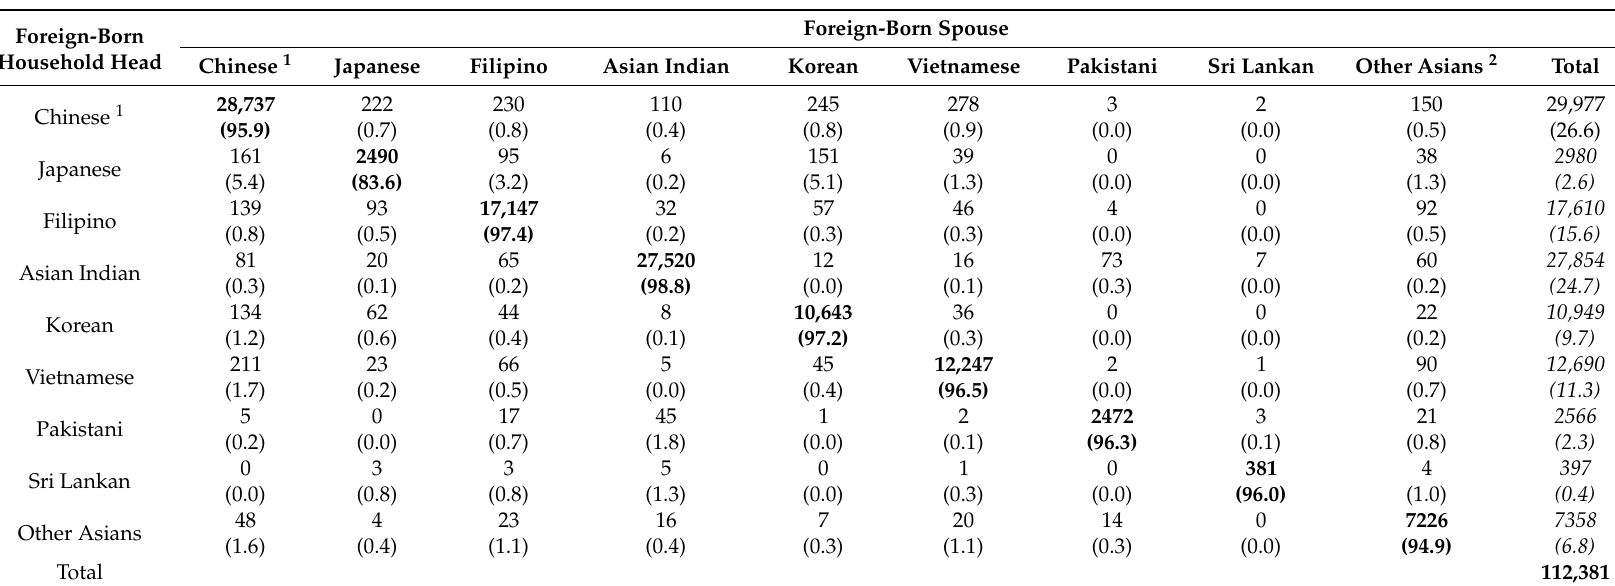
Table 3. Patterns of Intermarriages among Foreign-Born Asian Groups by Foreign-Born Household Heads and Foreign-Born Spouses, ACS 2008–2012. Foreign-Born Household Head